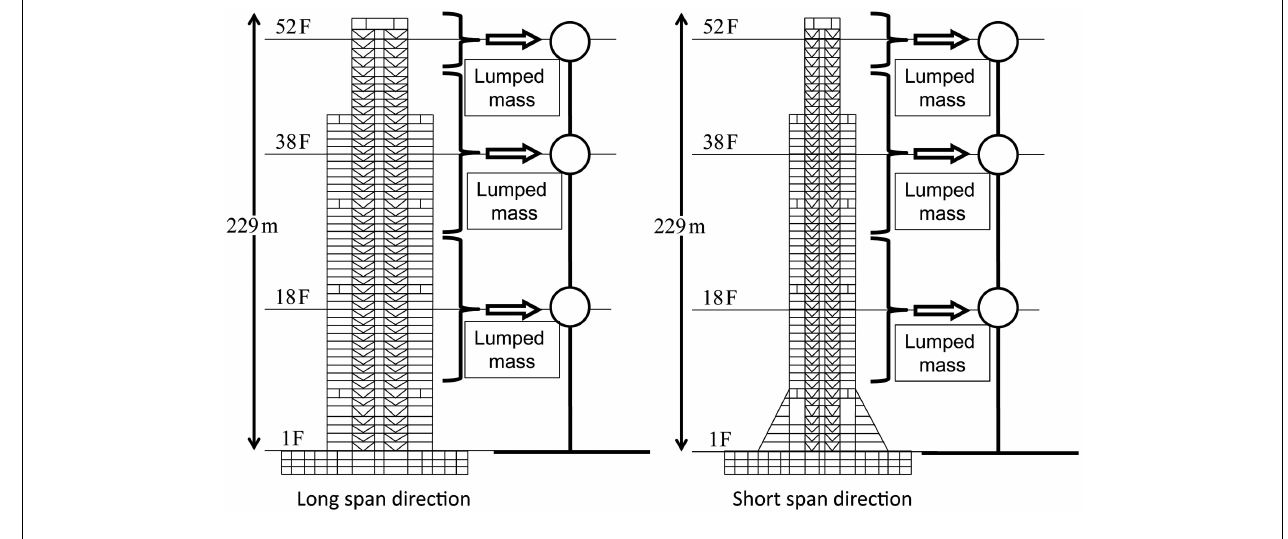
FIGURE 1 | Super high-rise building at Osaka bay area .